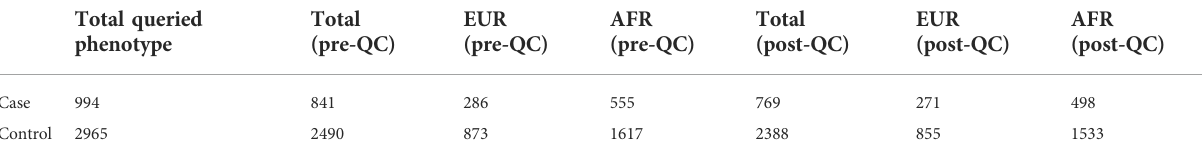
TABLE 1 COVID-19 pediatric case – control cohorts